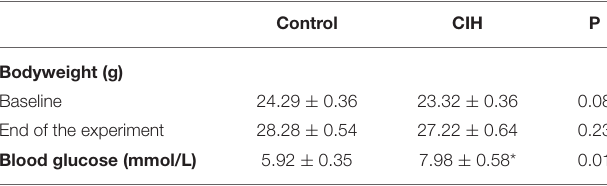
TABLE 1 | Basic characteristics of mice exposed to CIH or